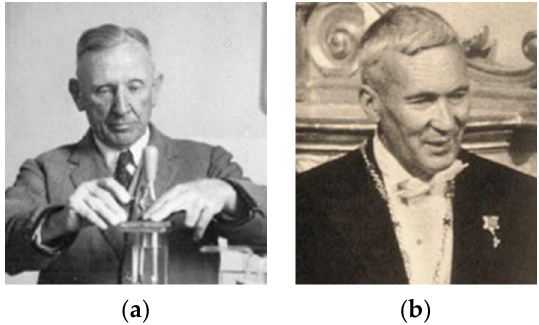
Figure 1. ( a ) In 1951, H.E. Hurst discovered the clustering behavior in nature while ( b ) A.N. Kol- mogorov proposed a decade before a stochastic process that describes this clustering behavior. Source: Wikipedia.